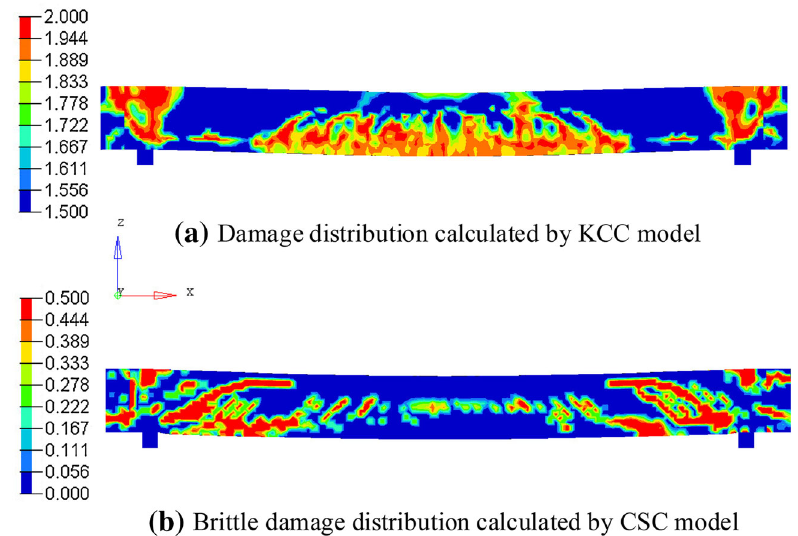
Fig. 5 Damage and deformation mode of B40 beam at t = 10 ms.